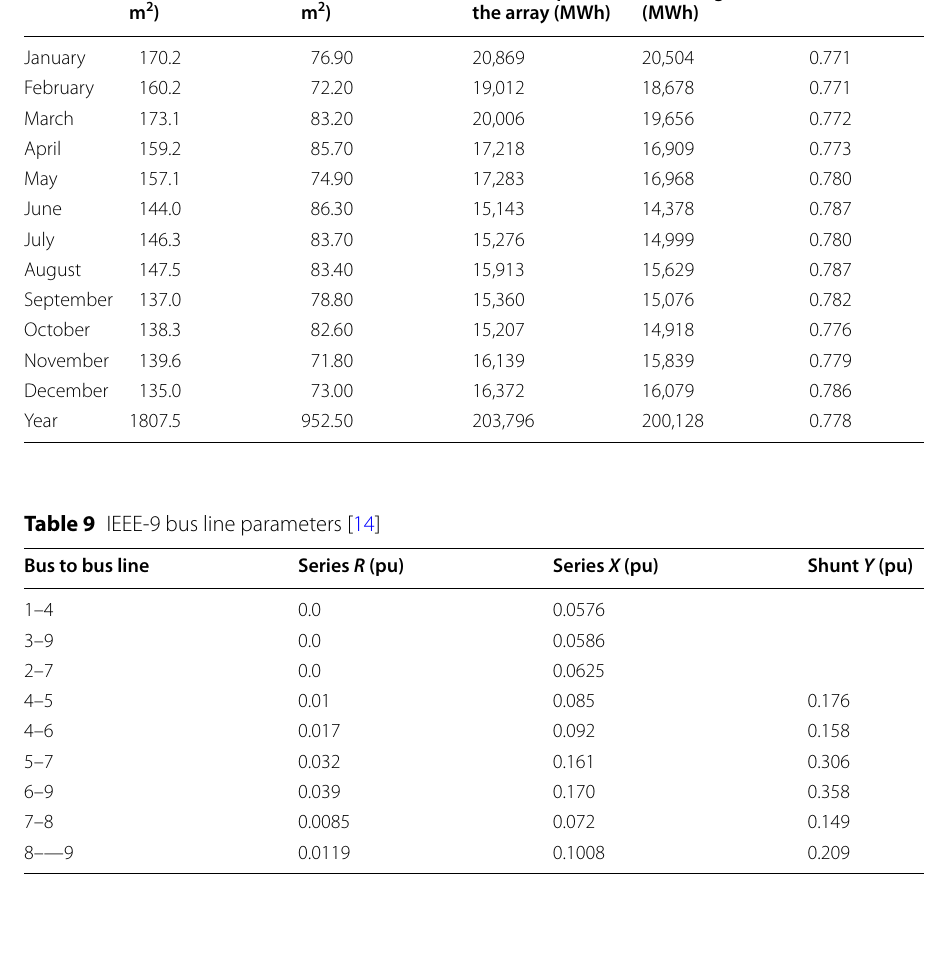
Table 10 Voltage profile of IEEE-9 bus at 12